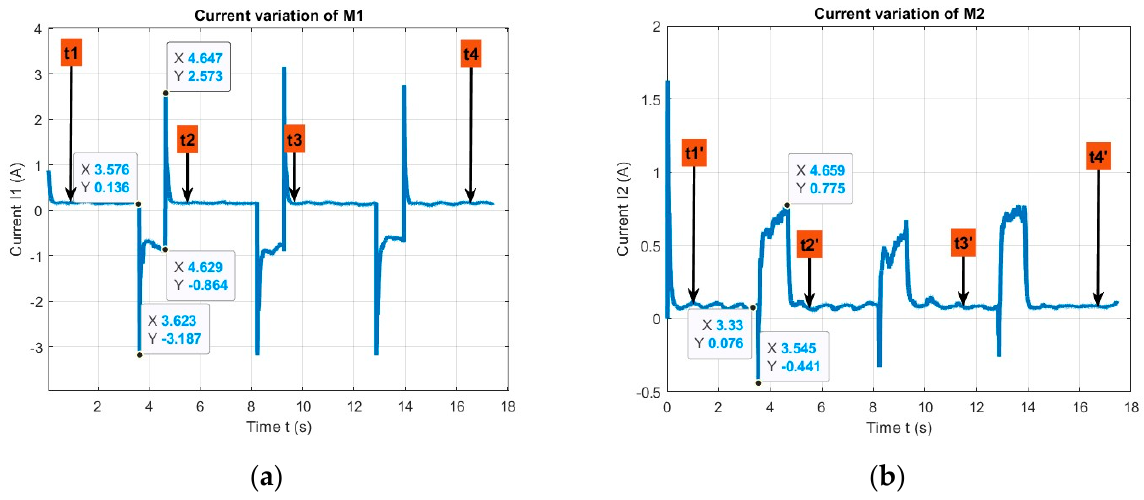
Figure 35. Current variation measured using the functional model for moving on the redefined path. ( a ) Wheel 1 (similar to wheel 3). ( b ) Wheel 2 (similar to wheel 4).